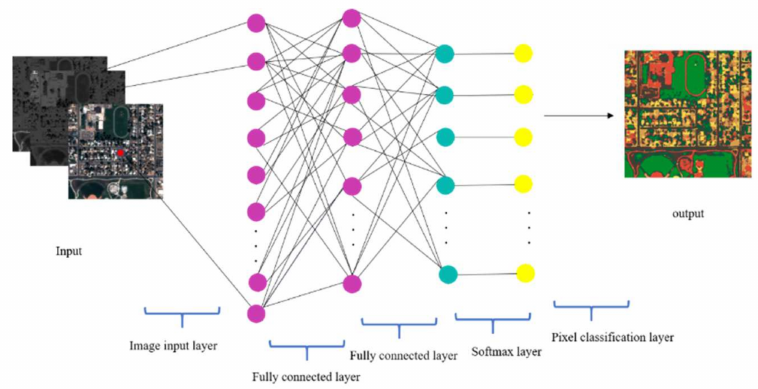
Figure 4. The architecture of the proposed